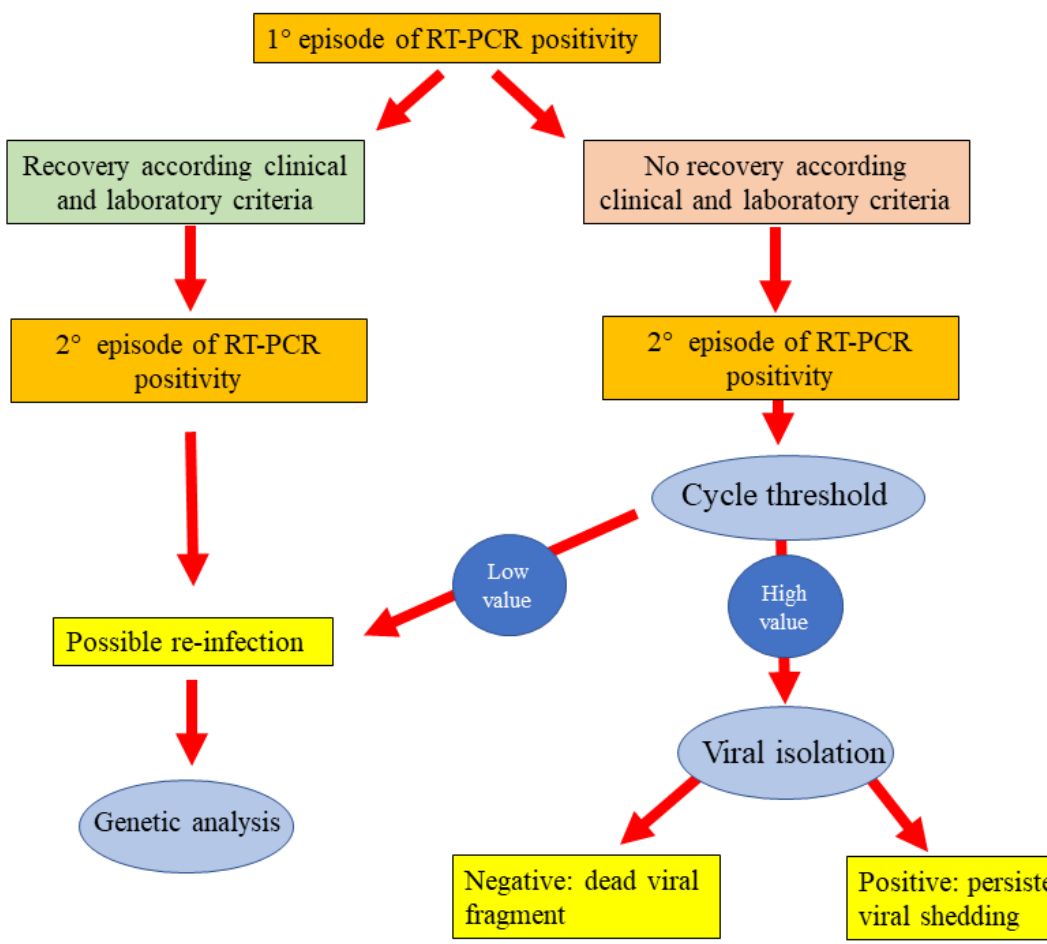
Figure 7. Flow diagram in order to determine the cause of persistent RT-PCR positivity for SARS-CoV-2, modified by Raveendran, A.V. et al. [161] .